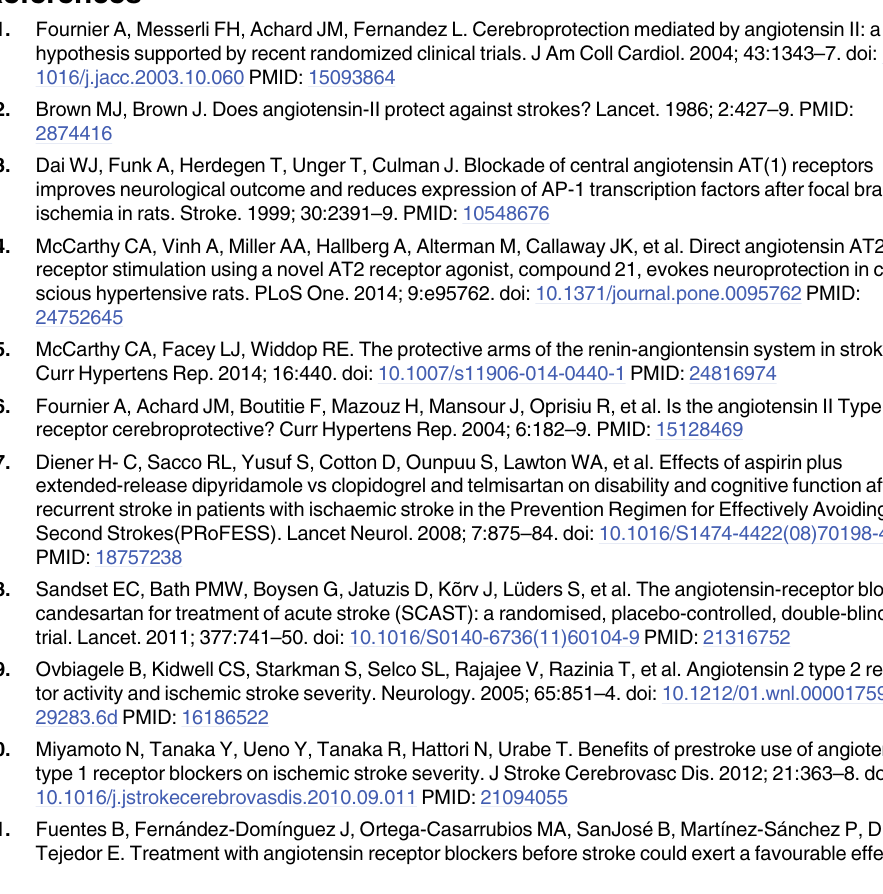
S2 Table. Association between types of antihypertensive drugs and ischemic stroke severity (Individual